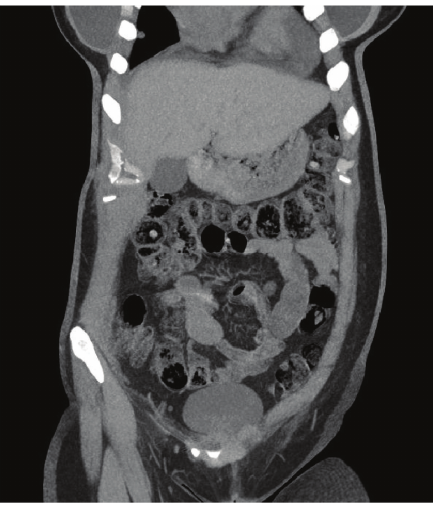
Figure 1: Abdominal CT scan with evidence of small bowel intussusception.